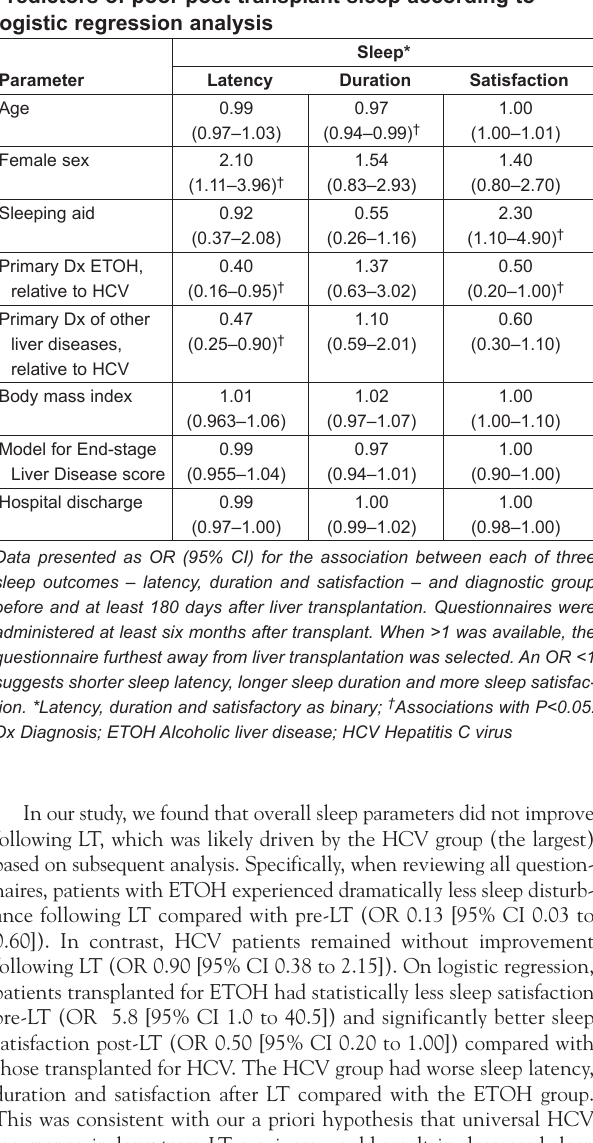
Table 2 Predictors of poor pretransplant sleep according